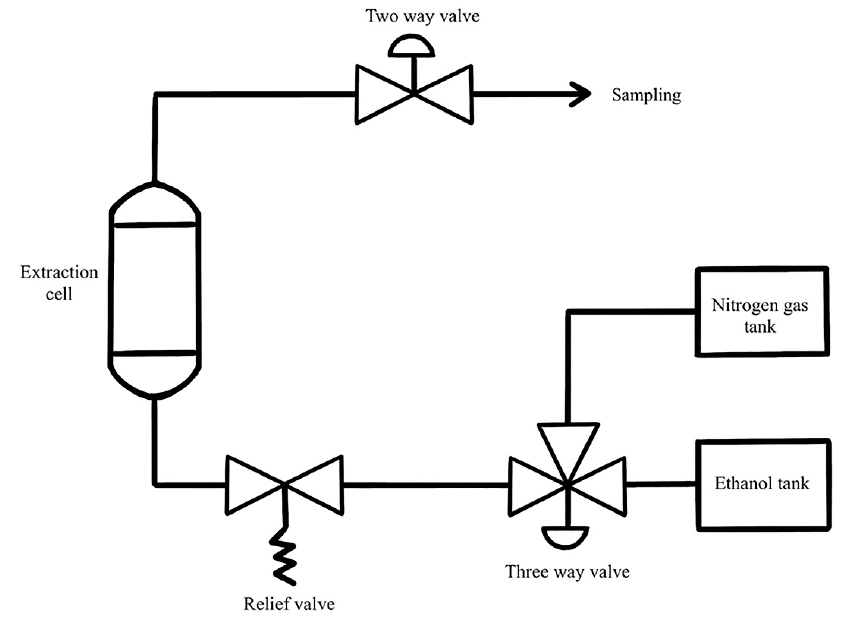
Figure 7. Pressurized liquid extraction set-up.